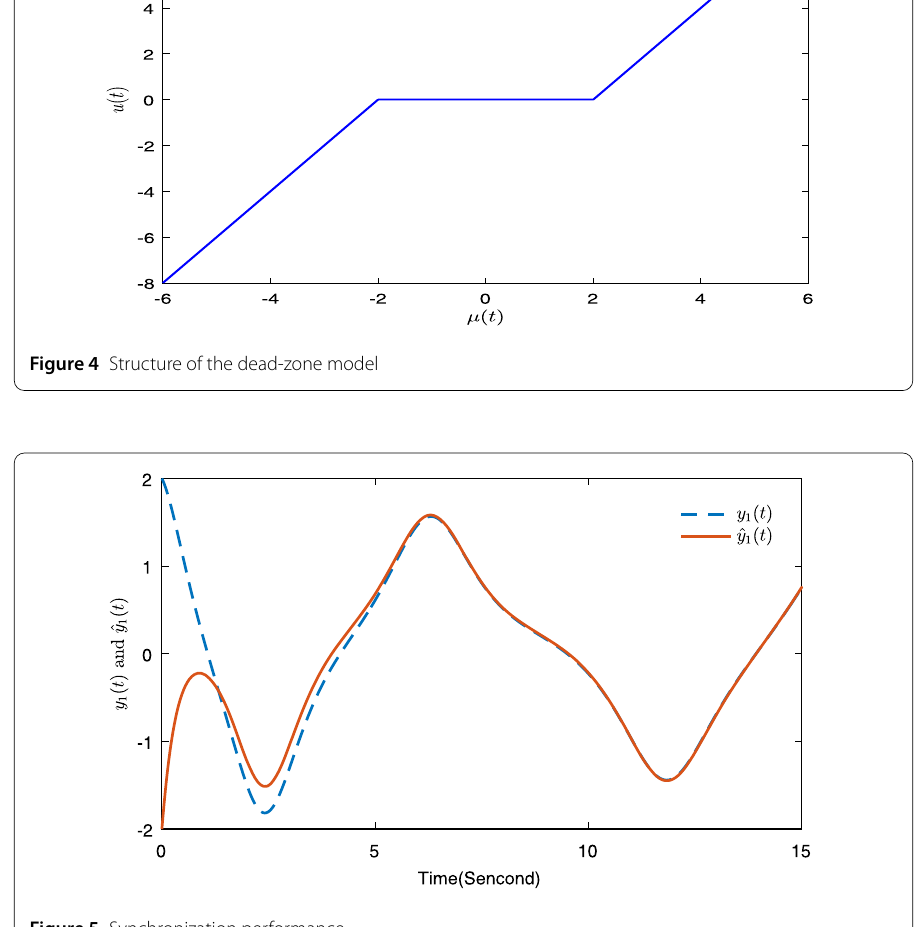
Figure 5 Synchronization